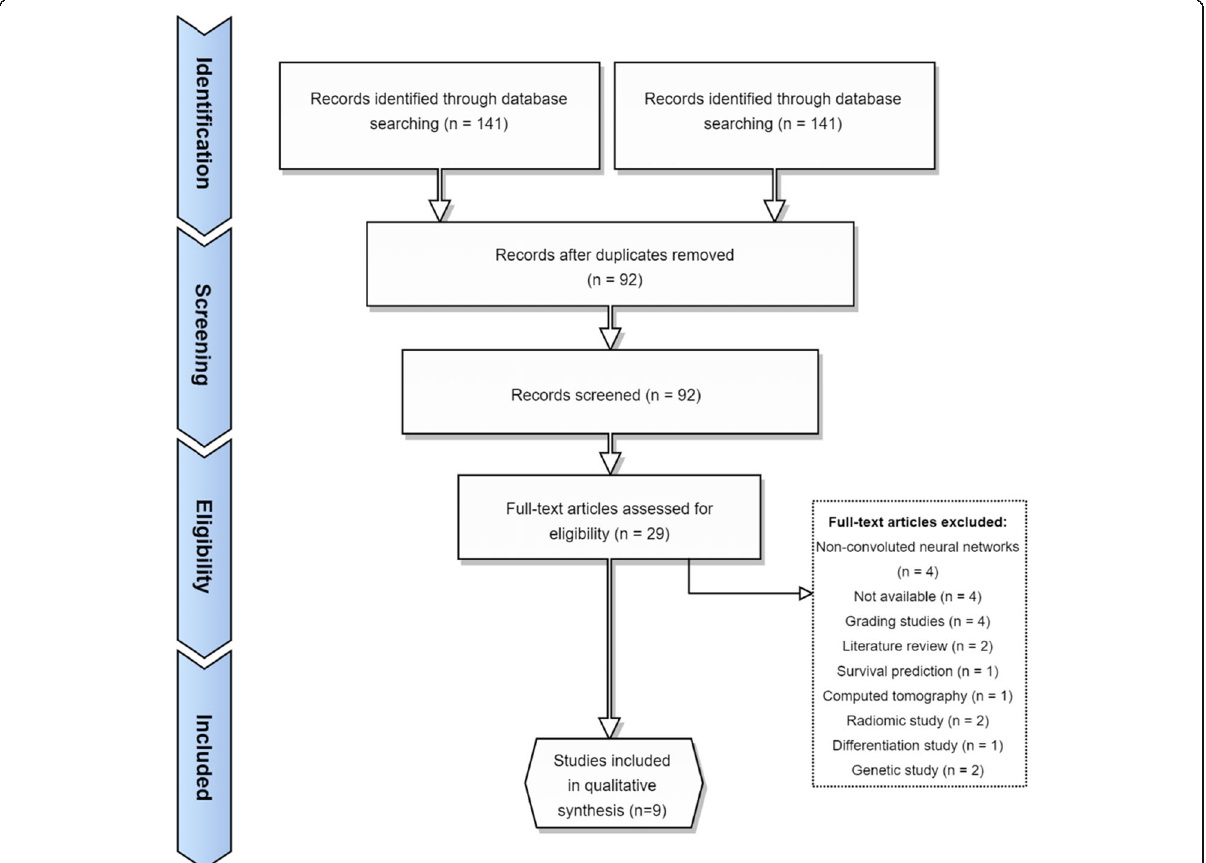
Fig. 5 PRISMA flowchart for search performed on the 24 October